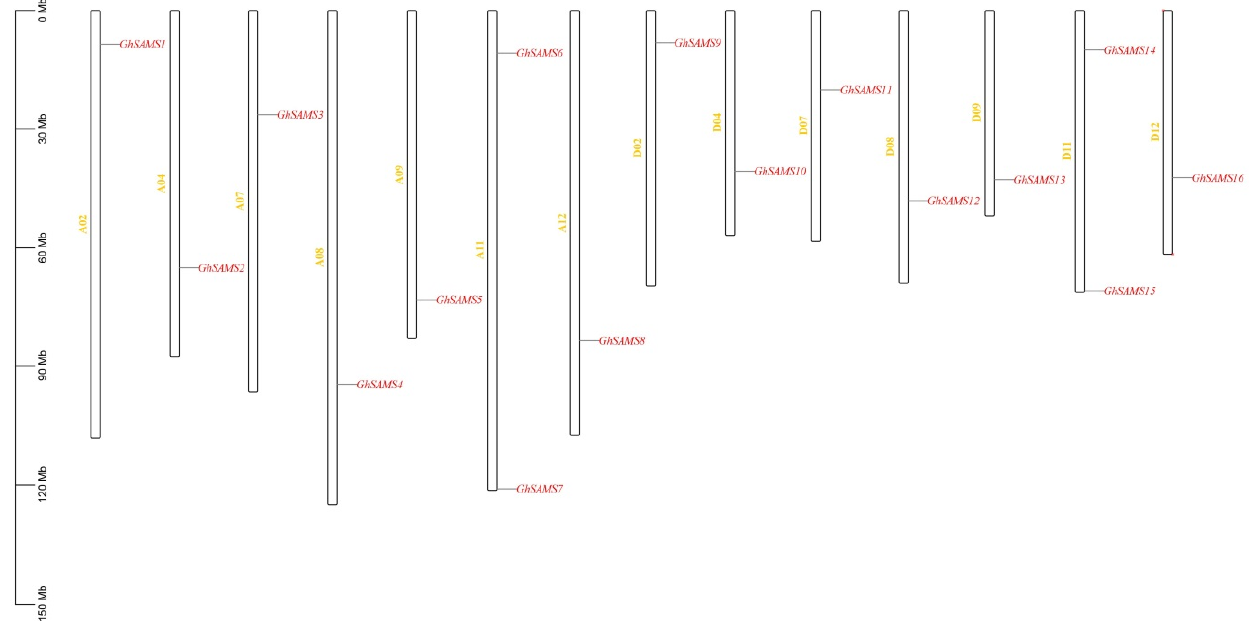
Figure 3. Chromosome distribution of upland cotton SAMS genes.